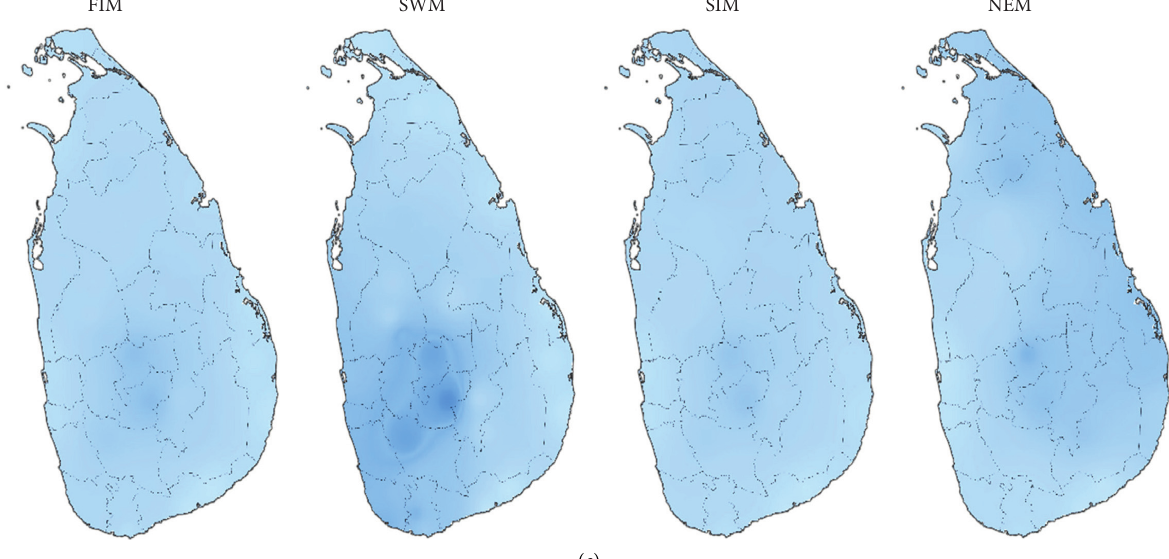
Figure 7: Far-future indices under RCP4.5 (2071–2100). (a) For normalized DI. (b) For normalized WI. (c) Moisture index.